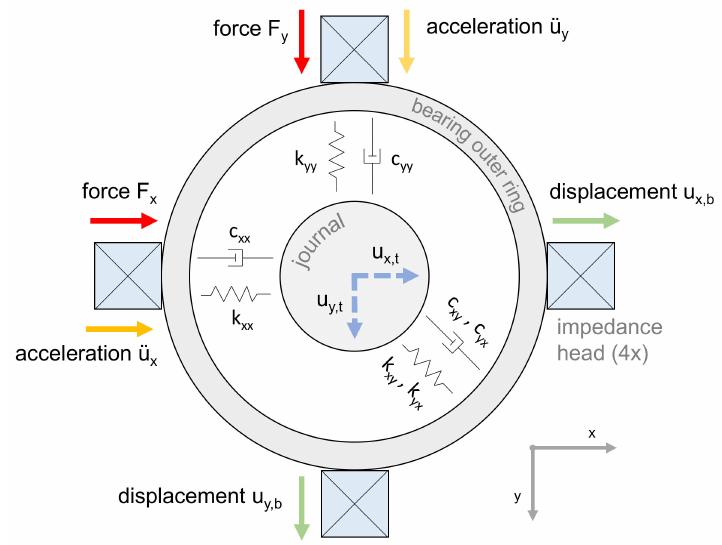
Figure 3. Simplified 2D model for the data